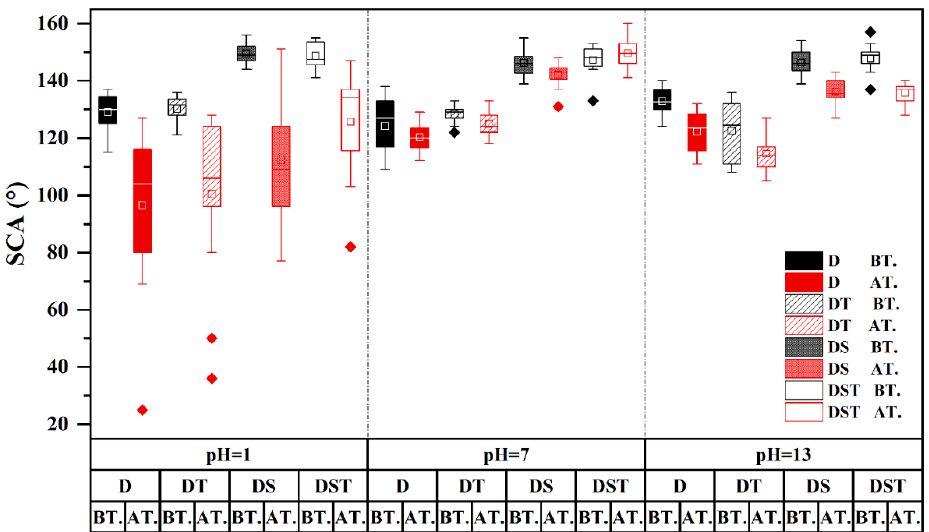
Figure 11. Changes in the contact angles of the samples immersed in solutions with different pH values for 24 h. BT, before treatment; AT, after treatment.